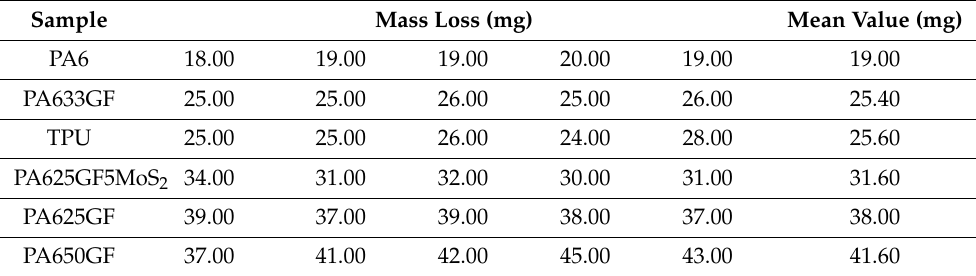
Table 3. Mass loss readings of the polymeric and composite samples after wear test .